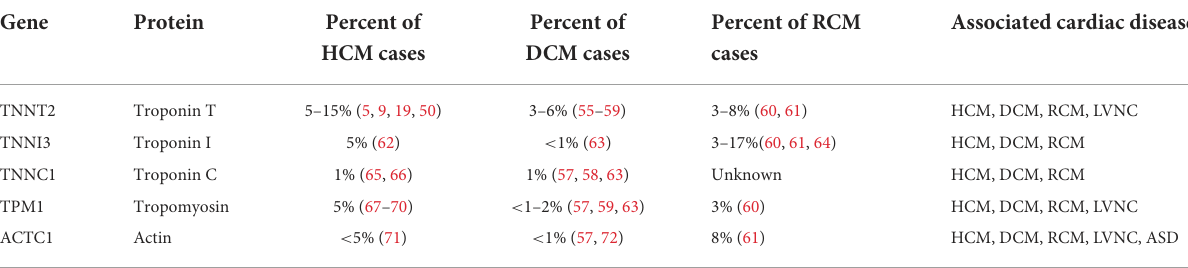
TABLE 1 Genes associated with thin filament cardiomyopathies and estimated incidences.